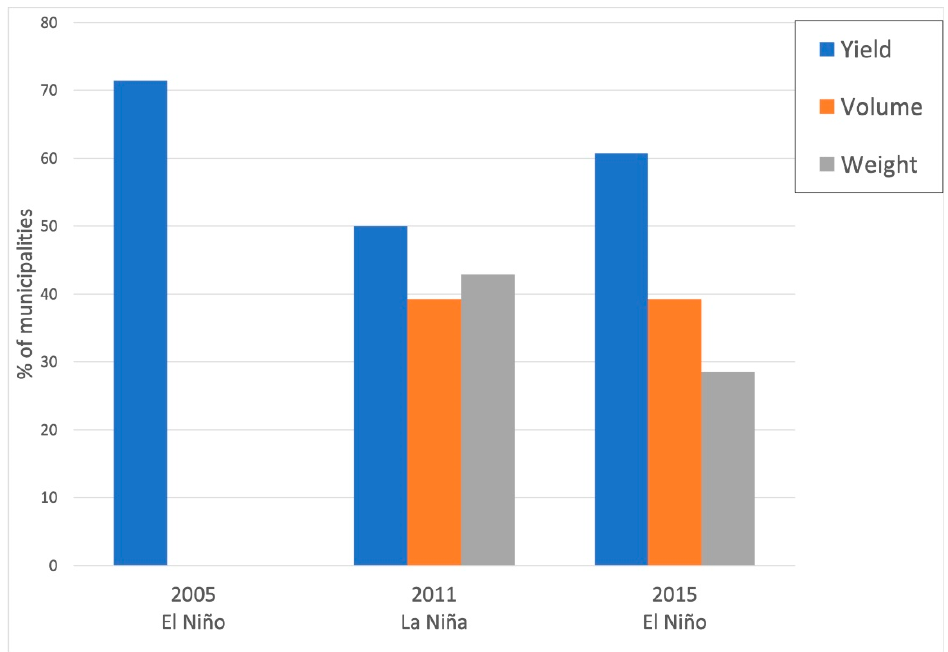
Figure 4. Percentage of affected municipalities during El Niño and La Niña events in terms of corn yield, cattle volume, and cattle weight variables. yield, cattle volume, and cattle weight